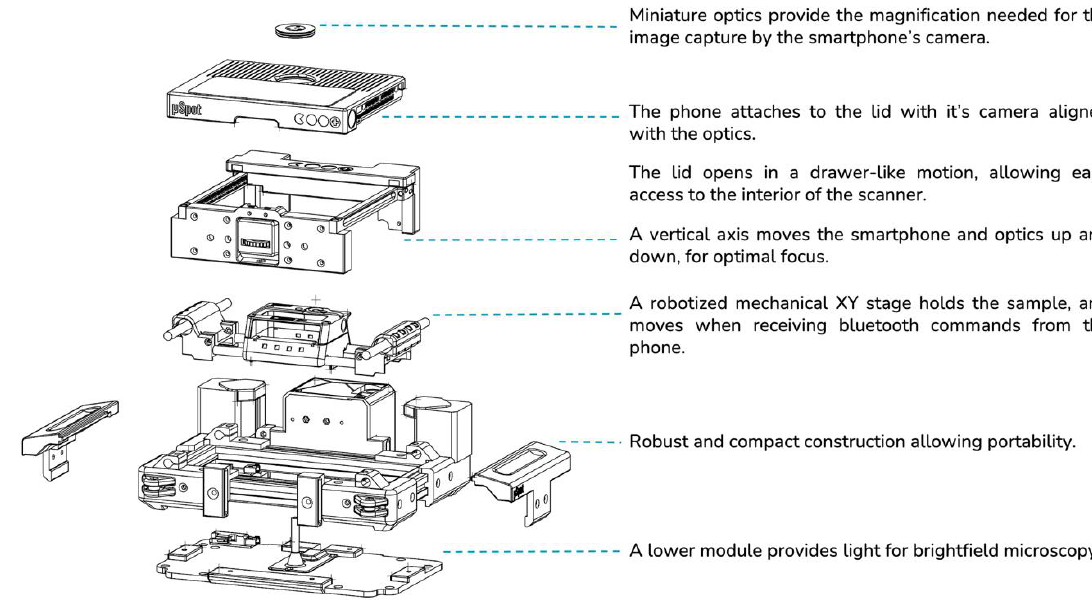
Figure 2. Exploded view of the proposed microscope scanner.